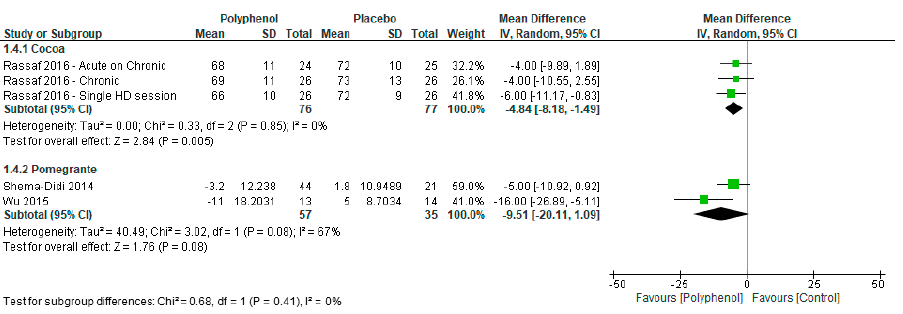
Figure 4. Sensitivity analysis of polyphenol-rich interventions on systolic blood pressure.